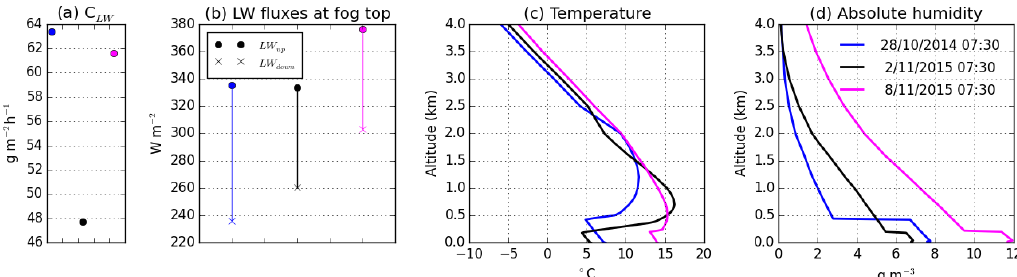
Figure 6. Comparison of three fog events at 07:30UTC: (a) C LW (defined in Sect. 2.1); (b) LW fluxes at fog top (cross is downwelling, circle is upwelling, thus length of vertical line indicates the (negative) LW budget at fog top). (c) Temperature and (d) humidity profiles estimated with the method described in Sect. 3.3. The fog top is located at the bottom of the sharp temperature inversion.